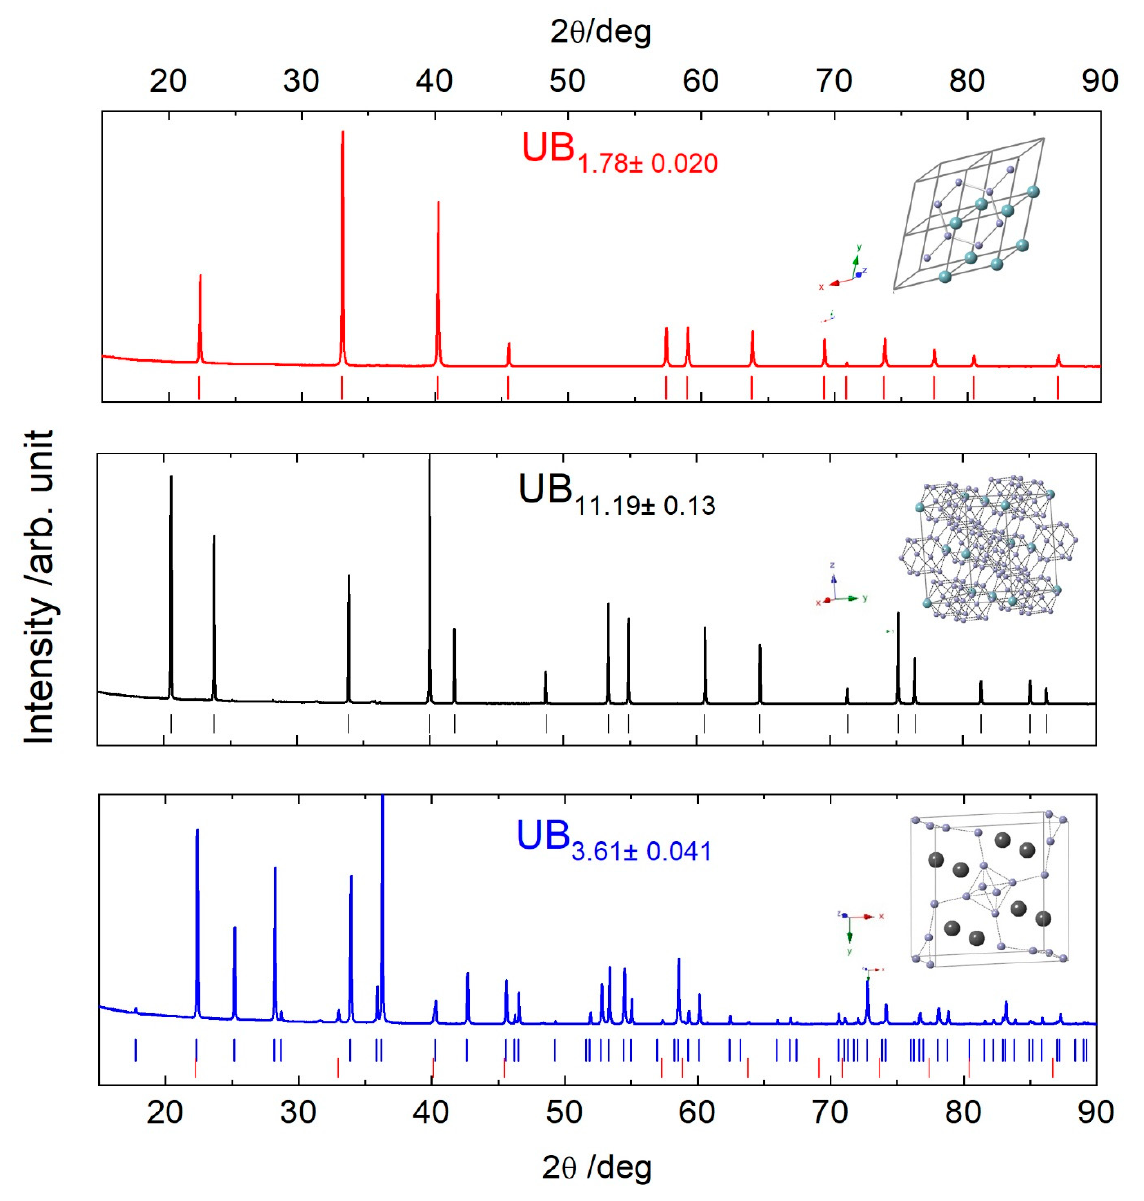
Figure 1. X-ray diffraction patterns and structures of the uranium borides. The uranium atoms are bigger than the B atoms.